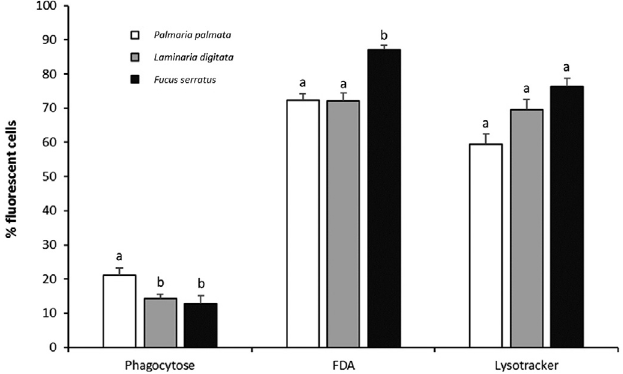
Fig. 2. Concentration of circulating hemocytes (in millions cells ml (cid:3) 1 ), after one, two and three months of experimentation, as a function of the diet: P. palmata, L. digitata and F. serratus (Experimentation E6). Results are expressed as mean ±SEM ( n = 9). At each date, diets that do not share a letter differ signi fi cantly (ANOVA and SNK tests, p < 0.05).